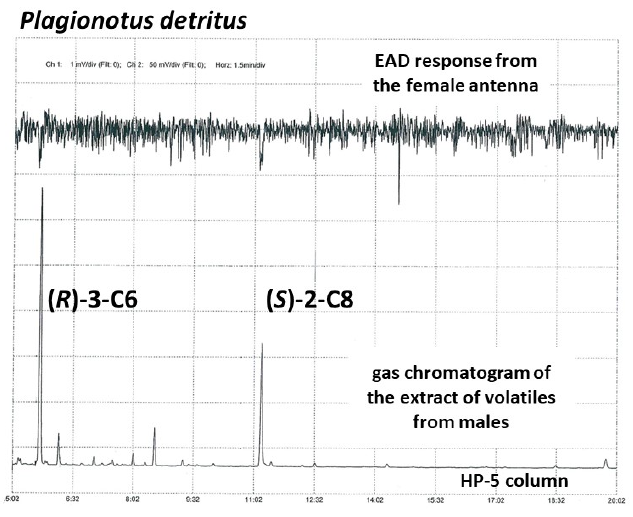
Figure 2. Representative GC-EAD trace of antennal response profile of a female Plagionotus detritus to male-produced volatiles. Top trace shows the antennal response, the bottom trace shows the corresponding gas chromatogram. Antennal responses to ( R )-3-hydroxyhexan-2-one [( R )-3-C6] and ( S )-2-hydroxyoctan-3-one [( S )-2-C8] are